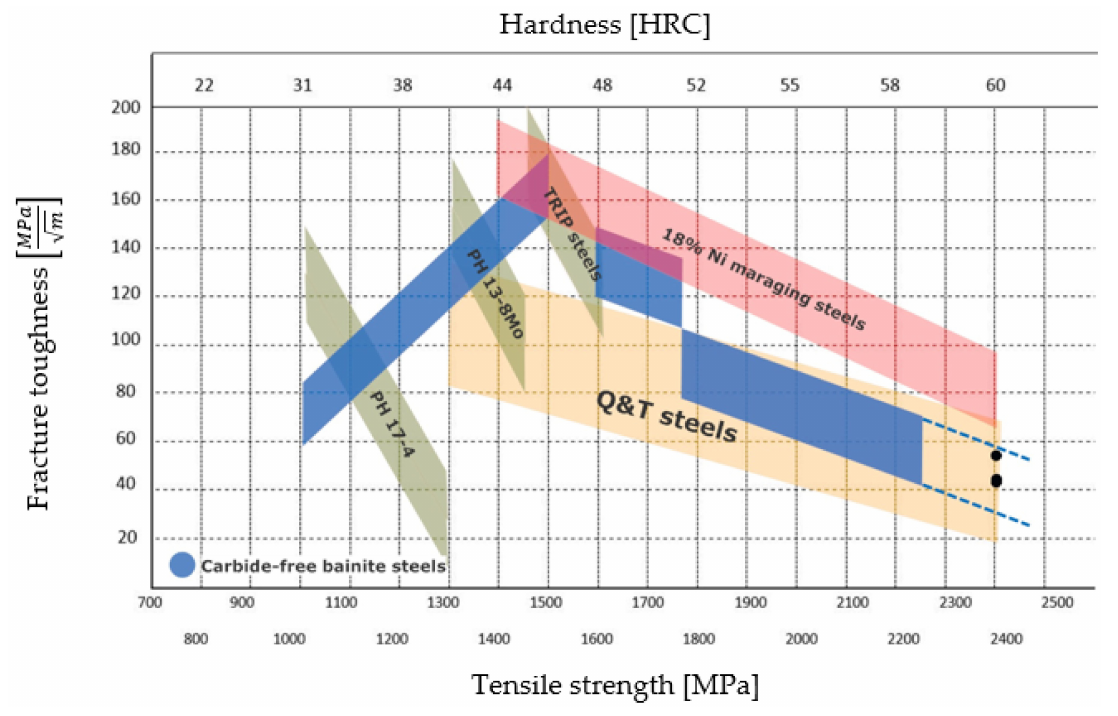
Figure 11. Fracture toughness data for some ultra-high strength steels. Table 3. Summary of